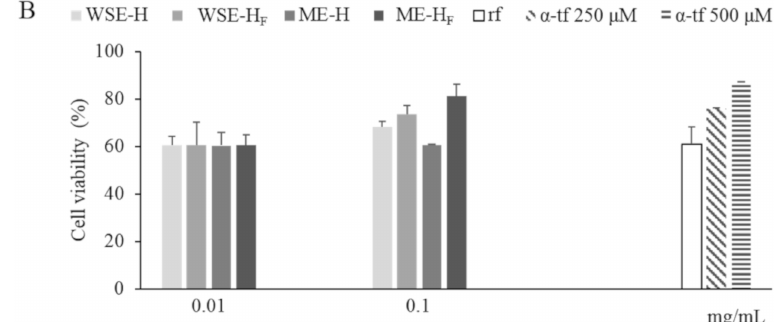
Figure 5. Cell viability of human keratinocytes treated with freeze-dried WSE-H and WSE-H F and ME-H and ME-H F at di ff erent concentrations (0.01–10 mg / mL). Cell viability of non-stressed cells (CTRL) is also reported (Panel A ). Protective e ff ect of freeze-dried WSE-H and WSE-H F and ME-H and ME-H F at concentrations of 0.01 and 0.1 mg / mL and α -tocopherol ( α -tp; 250 and 500 µ M) on the cell viability of human keratinocytes subjected to oxidative stress induced by hydroxide peroxide. The viability of H 2 O 2 -stressed cells incubated without antioxidant compounds (reference, rf) was also included (Panel B ). Data are the means of three independent experiments twice analyzed. Error bars are